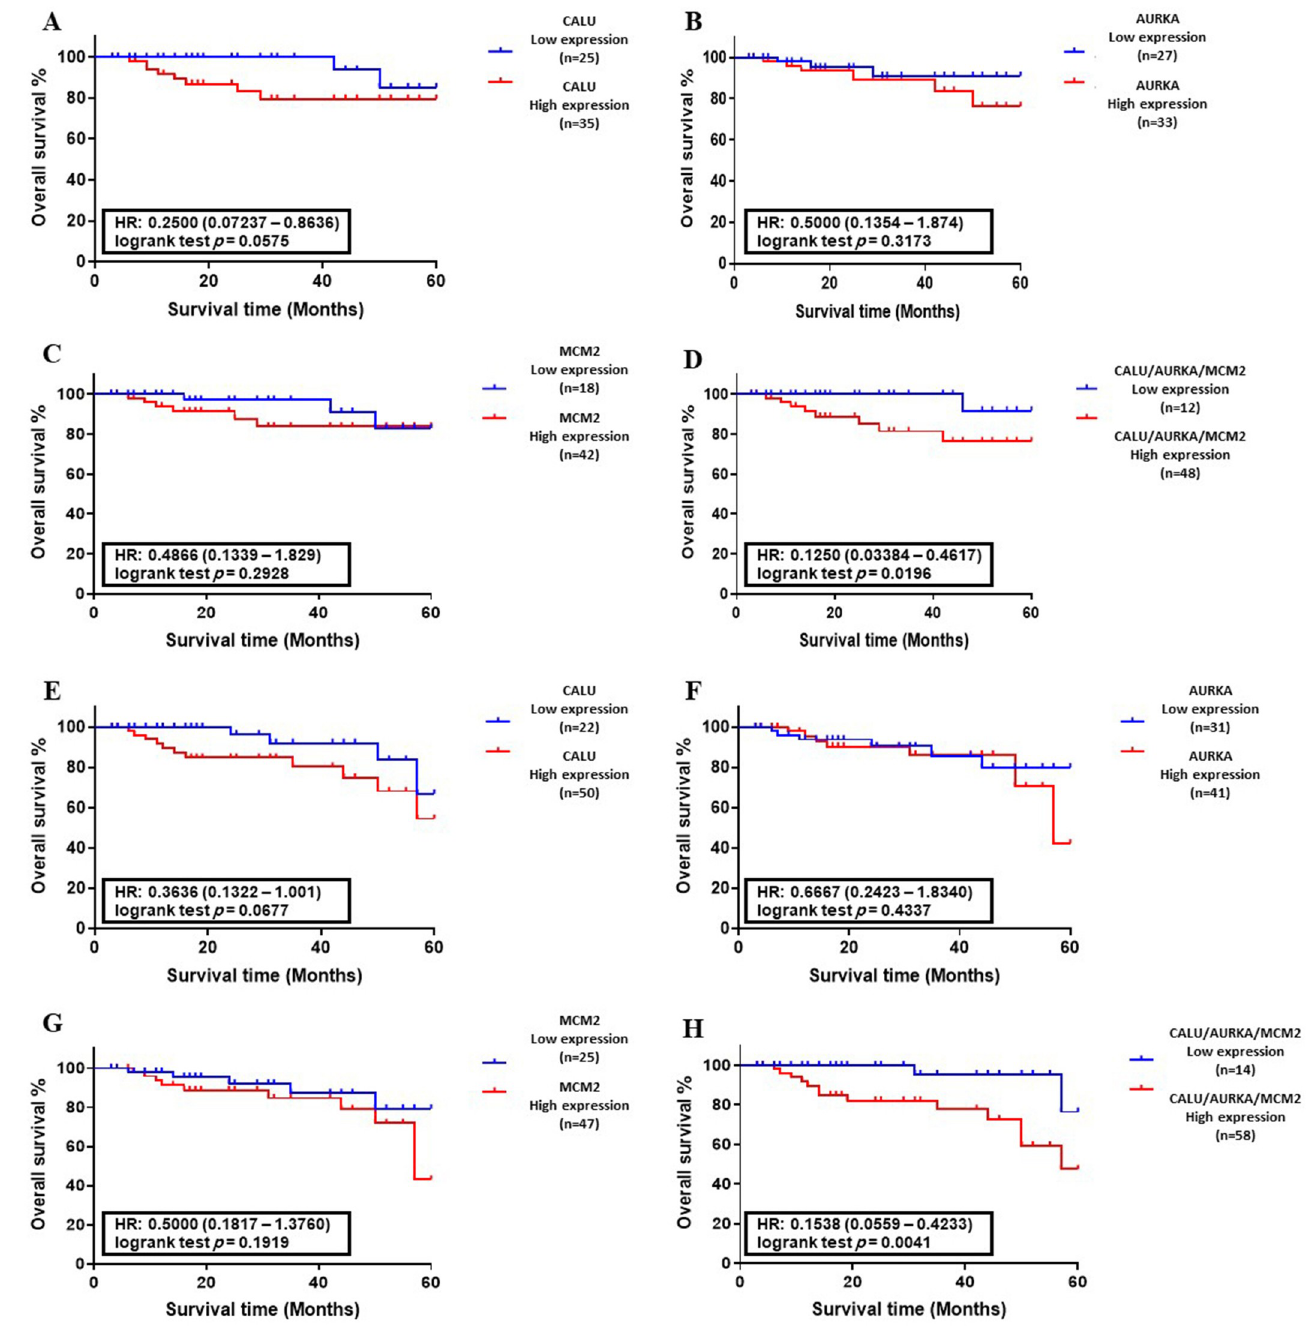
Fig 6. Association between DEGs expression and overall survival (OS) of colon cancer patients. (A-D) Kaplan–Meyer analysis of CALU, AURKA, MCM2, and CALU/AURKA/MCM2 panel in the training set (n = 107). (E-H) Kaplan–Meyer analysis of CALU, AURKA, MCM2, and CALU/AURKA/MCM2 panel in the validation set (n = 132). Data indicated that CALU, AURKA, and MCM2 in the form of a panel had a significant correlation with OS of colon cancer patients in training set ( P < 0.05) and validation set ( P < 0.01).